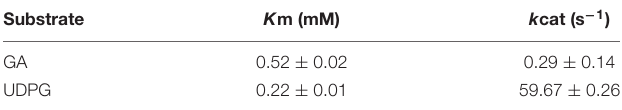
TABLE 1 | Enzymatic kinetic parameters of UGT109A3. Substrate